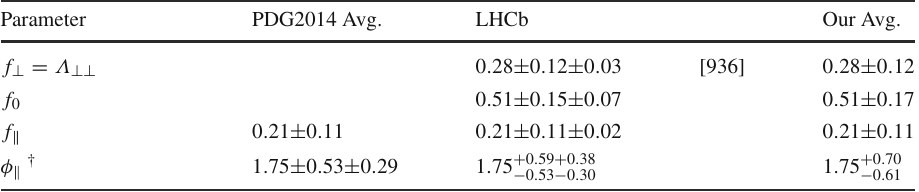
Table 255 Results of the full angular analyses of B 0 s → φ K this indicates that they are new published (preliminary) results since PDG2014 Parameter PDG2014 Avg. LHCb Our